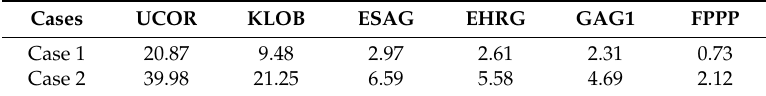
Table 8. The overall RMS based on all the stations for Case 1 and Case 2 (TECU).